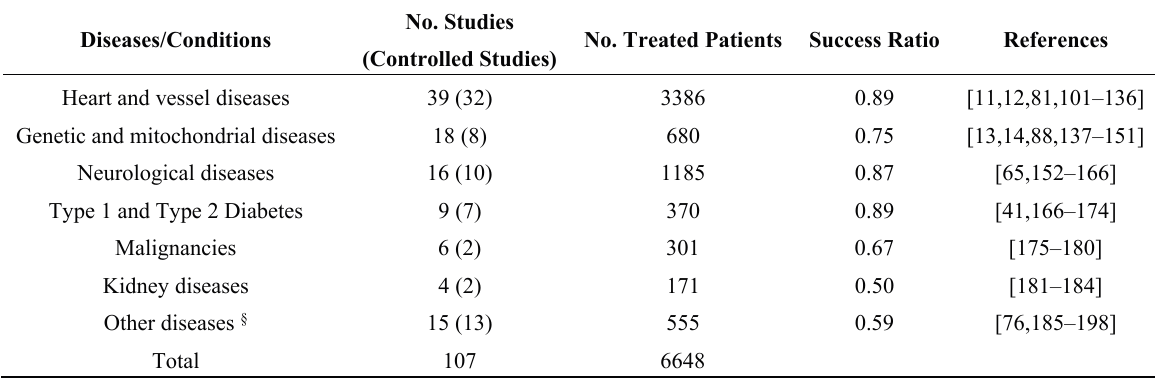
Table 2. Clinical studies utilizing coenzyme Q10 aimed at compensating OS/MDF-related pathogenetic